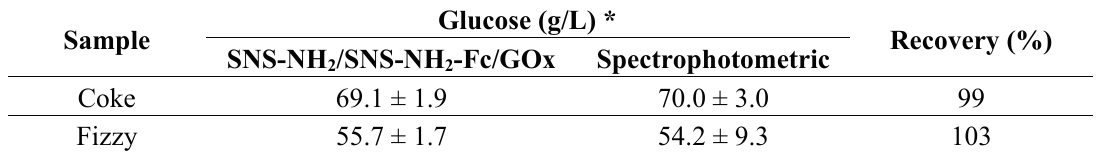
Table 3. Results for glucose analysis in real samples by of SNS-NH 2 /SNS-NH 2 -Fc/GOx biosensor and spectrophotometric